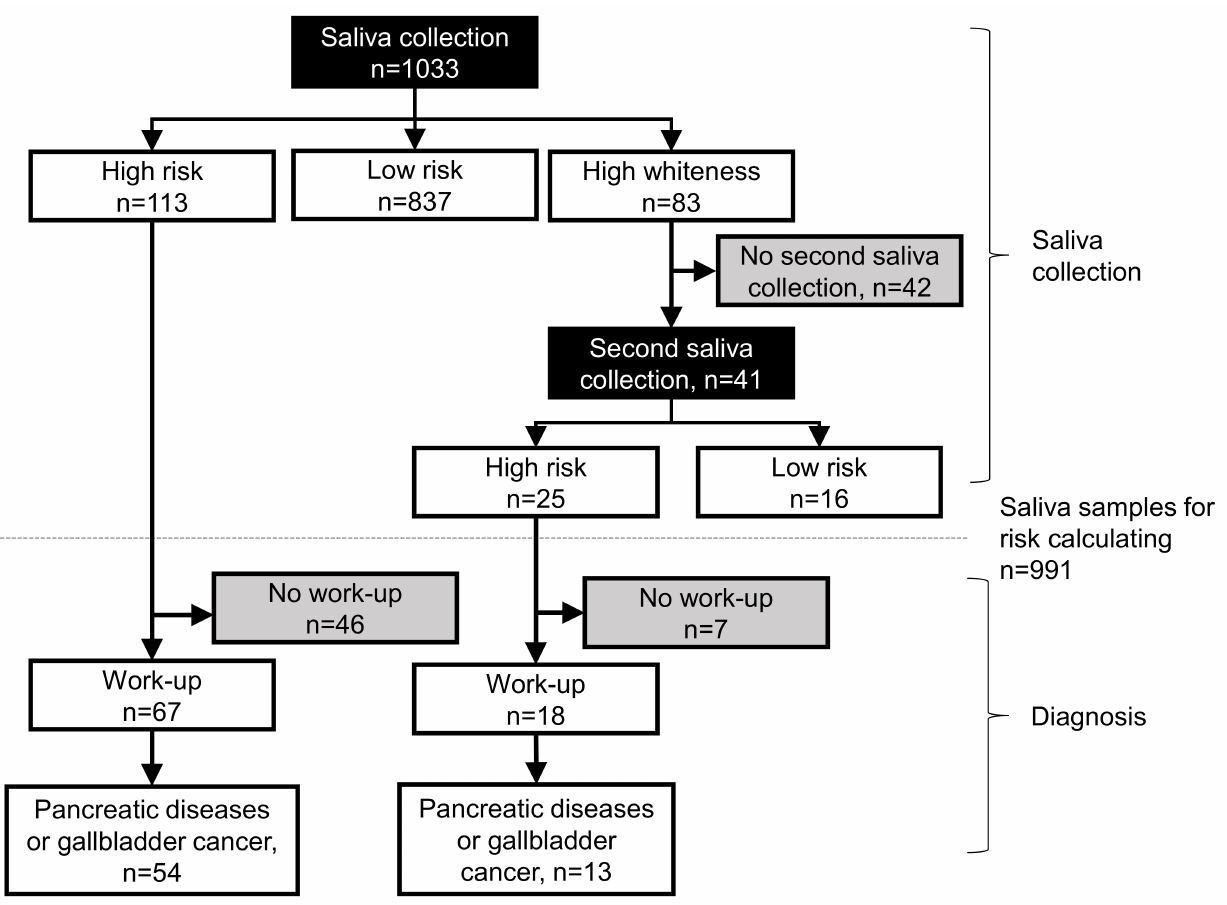
Figure 1. Flowchart of salivary test and diagnosis of pancreatic diseases. Black rectangles indicate saliva tests, and gray rectangles indicate participants that did not undergo saliva tests or pancre- atic